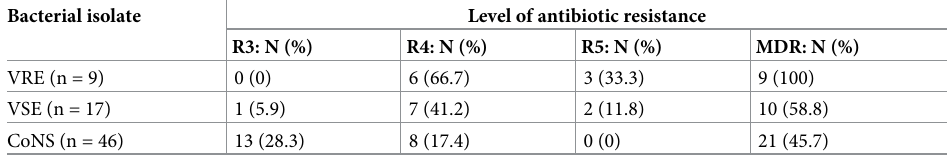
Table 4. Multidrug resistance level of VRE, VSE and CoNS isolates among patients attending at FHSCH, Bahir Dar, Ethiopia, 2020. Bacterial isolate Level of antibiotic